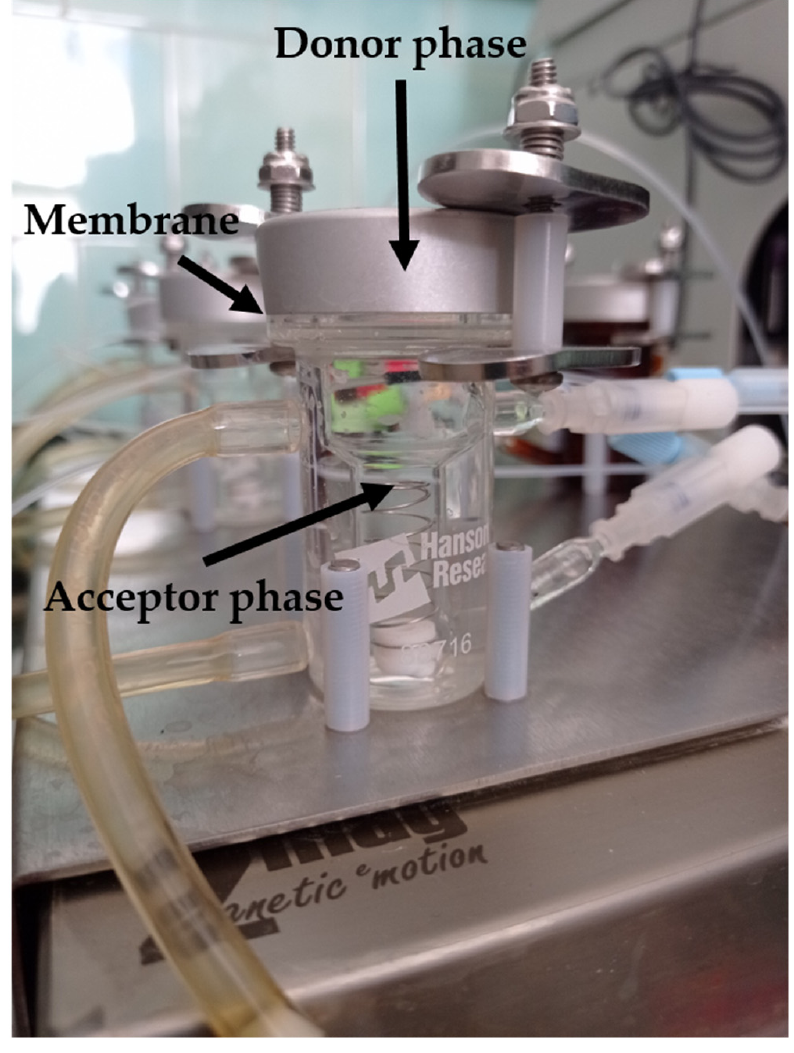
Figure 1. Illustration of Franz cell. Table 2. Comparison of reliable differences of Side-Bi-Side cell and Franz cell.